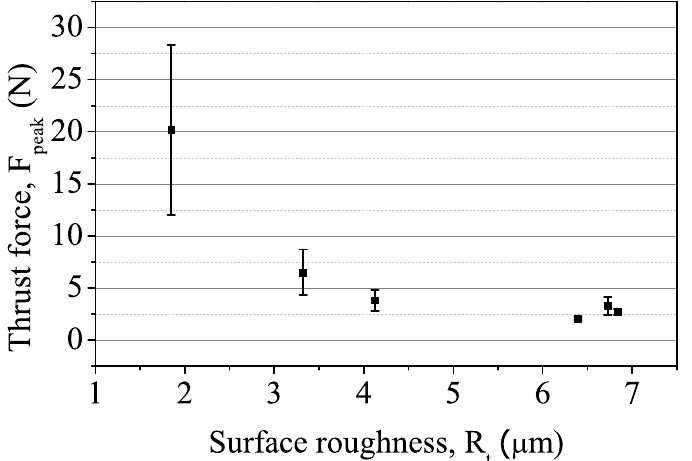
Figure 7. Thrust force (F peak ) according to different surface